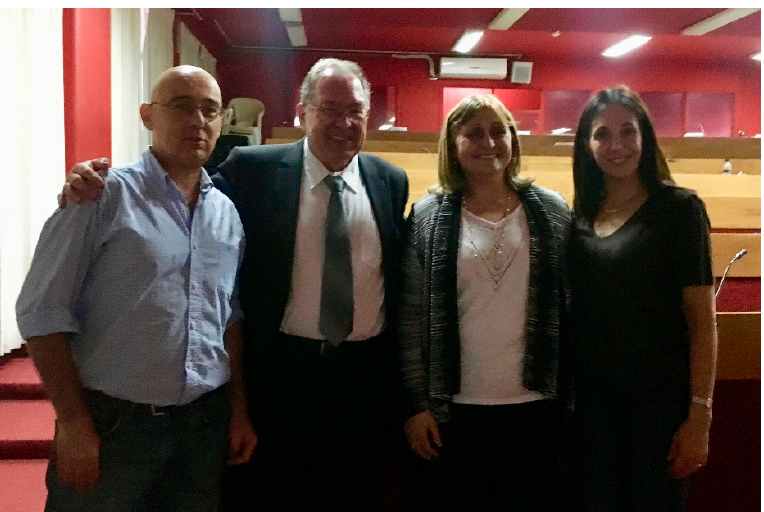
Figure 2. Honoris causa Doctorate in Uruguay, 2017. From left to right: the author, Bob, Maria H. Torre (then Dean of the School of Chemistry), and Ana María Ferreira.